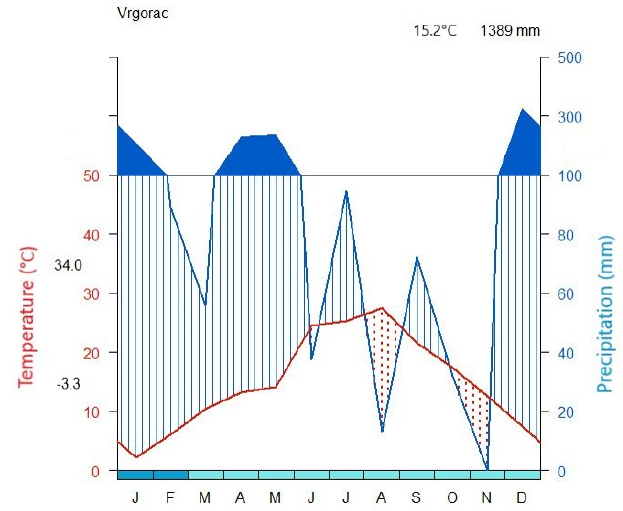
Figure 1. Walter–Lieth climatic diagram for average temperature (red line) and total monthly precipitation (blue line) per month at Vrgorac weather station in 2019. On the left axis, values in black represent the absolute maximum and minimum temperature. At the top right, values in black represent the average values of mean temperature and annual precipitation.